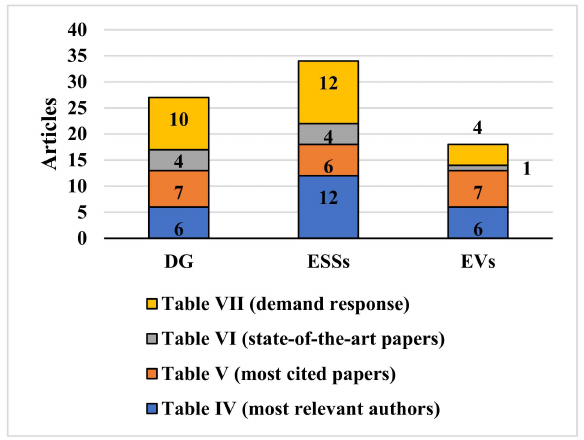
Figure 9. Comparison among the emphasis on distributed generation, energy storage systems, and electric vehicles in terms of published articles. Source: own study using data from Bibliometrix.